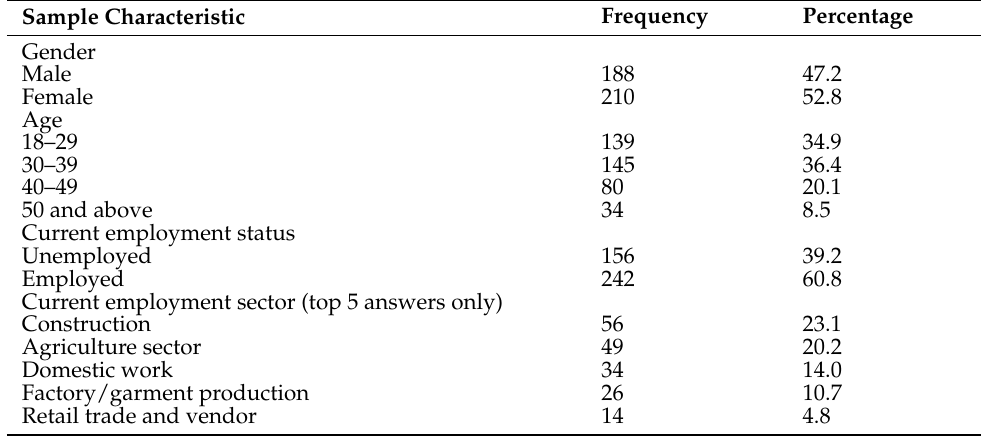
Table 1. Sociodemographic characteristics of the survey participants (n =